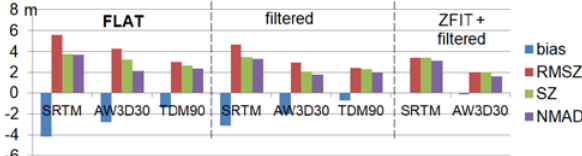
Figure 11. Accuracy results in open area of test site Flat